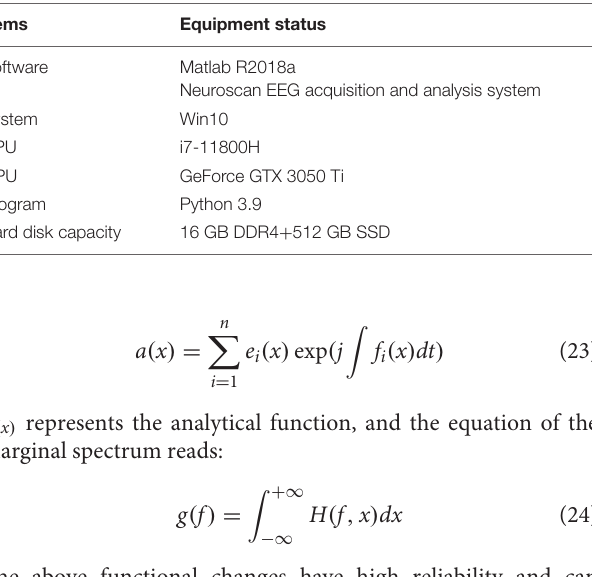
TABLE 1 | Software and hardware settings.